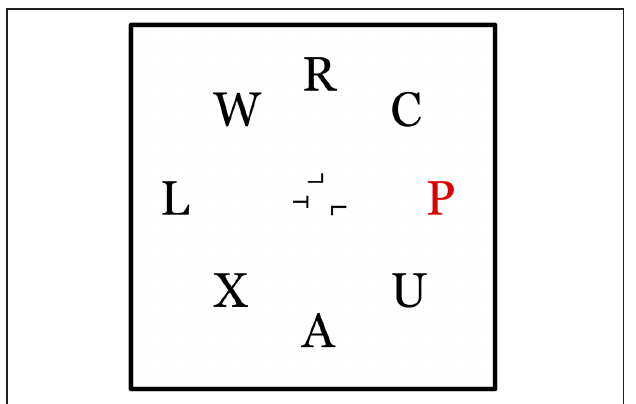
FIGURE 3 | After indicating the presence or absence of a red letter, participants were required to report the orientation of a rotated “T” presented among rotated “L”s in the center of the display (the “T” was either facing left or facing right). The second response was untimed. The display was on for 120ms.